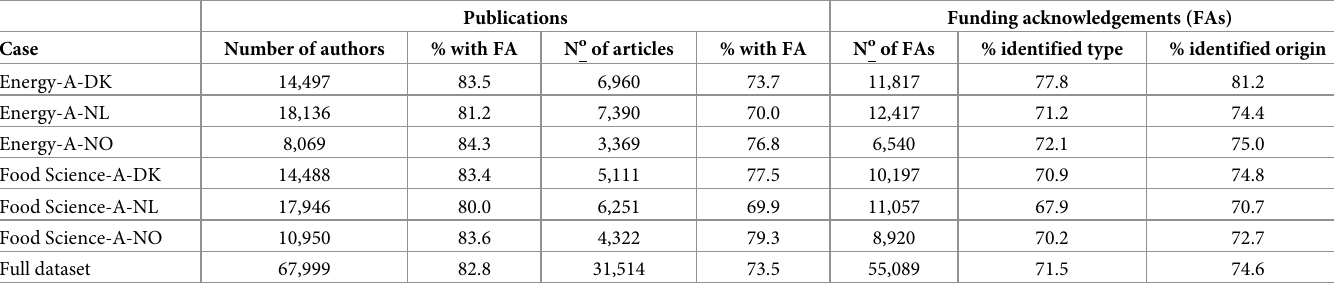
Table 4. Coded articles and FAs for Renewable Energy Research and Food Science, 2009–18.